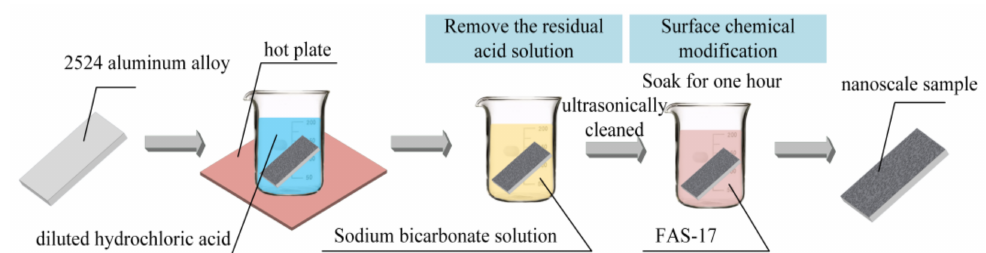
Figure 1. The wet etching procedure and key steps.